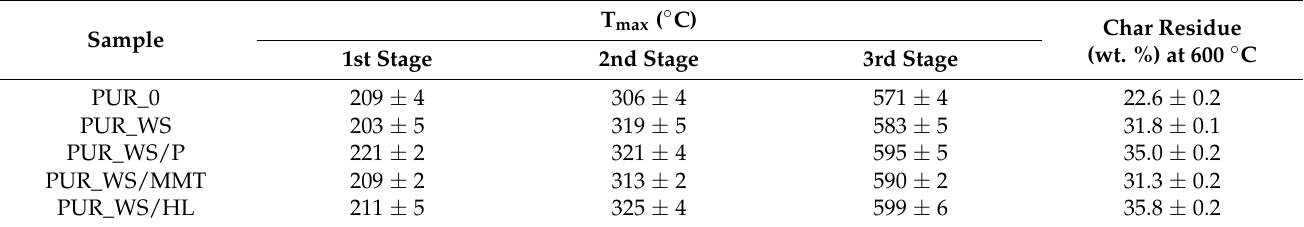
Figure 12. Thermogravimetric (TGA) and derivative thermogravimetry (DTG) results of ( a , b ) walnut shell fillers and ( c , d ) PUR composites. Table 4. The results of thermal stability of PUR composites.